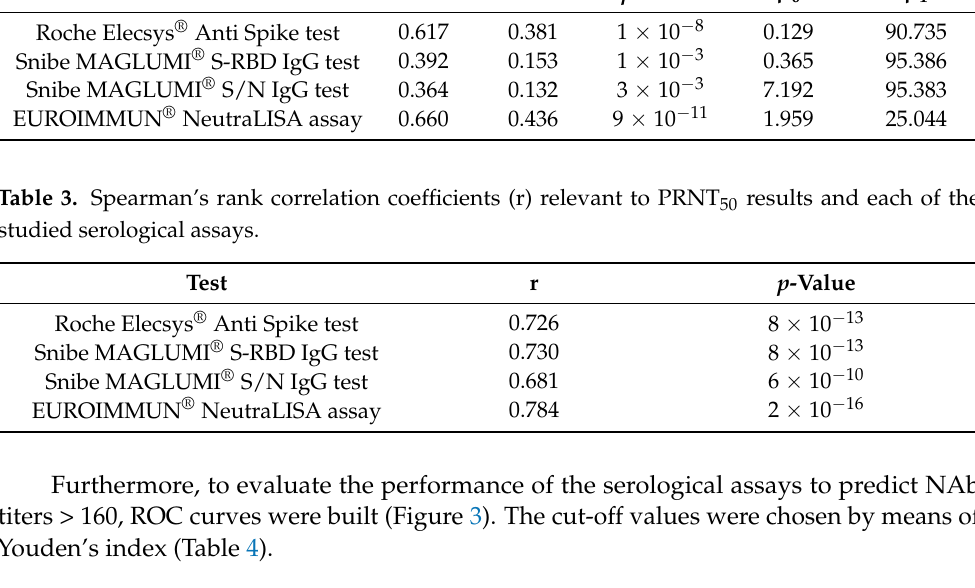
Table 4. Optimized parameters from the ROC curves, calculated by the Youden’s index, relevant to each serological